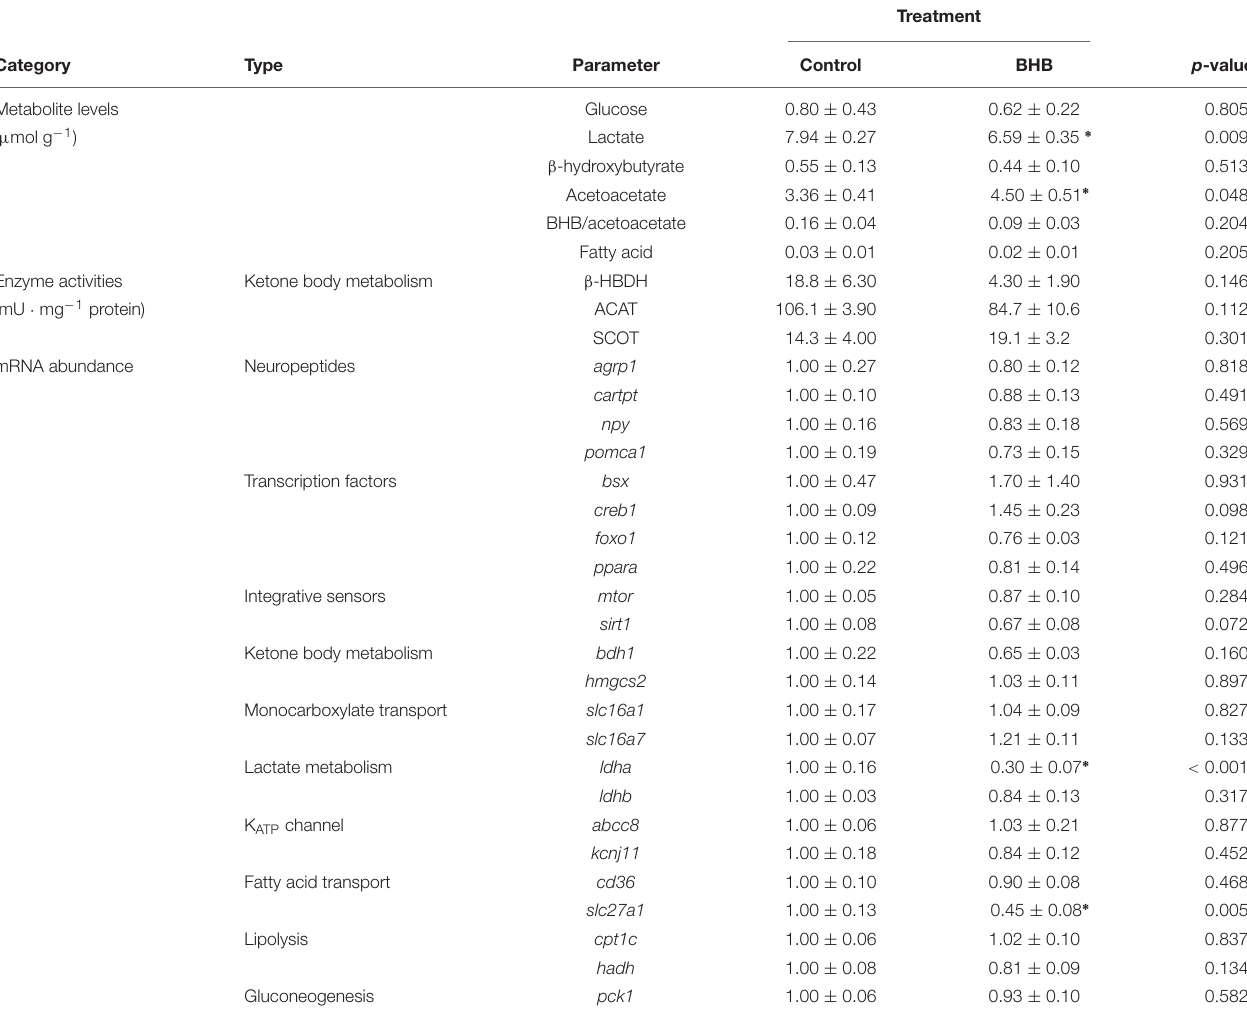
TABLE 4 | Levels of metabolites, enzyme activities, and relative mRNA abundance of transcripts in hindbrain of rainbow trout 6 h after intracerebroventricular administration of 1 µ L 100 g − 1 body mass of saline solution alone (control) or containing 0.5 µ mol of β -hydroxybutyrate (BHB).